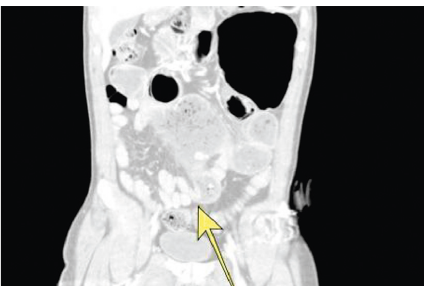
Figure 1: Computed tomography image demonstrating the small bowel obstruction secondary to the phytobezoar. A transition point is seen in the midline lower abdomen in the region of the proximal ileum, with distended proximal small bowel loops containing fecalized material and decompressed distal small bowel loops (yellow arrow). There is a similar appearance of the distended left upper quadrant bowel anastomosis site, as well as within the side- to-side small bowel anastomosis in the midabdomen. A small amount of mesenteric fluid is seen, without significant ascites, small bowel wall thickening, differential mucosal enhancement, or pneumatosis to indicate bowel compromise.